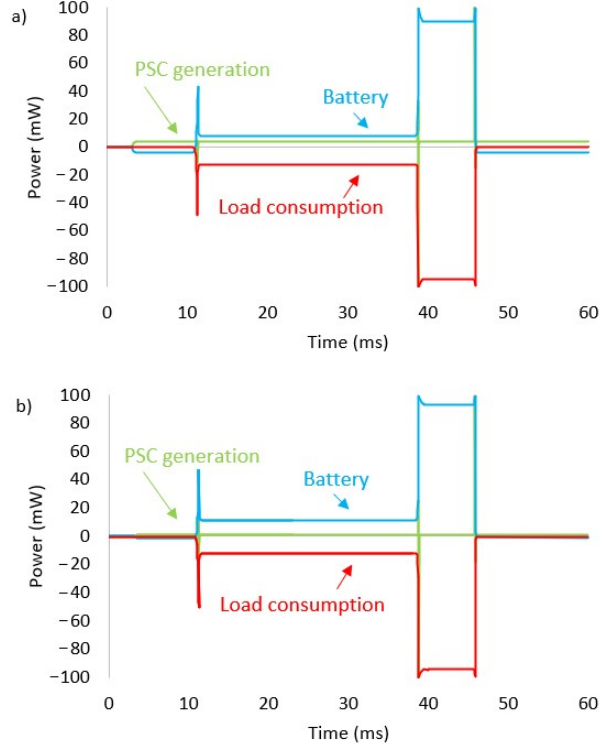
Figure 6. PSC energy harvesting system simulations for ( a ) 1 sun and ( b ) 1000 lux light levels. The green line represents PSC generation, the blue line—battery charge/discharge, and the red line—the load.